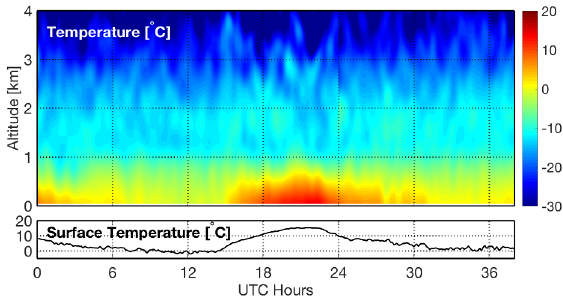
Figure 3: First temperature measurements taken with the described combined DIAL/HSRL system.